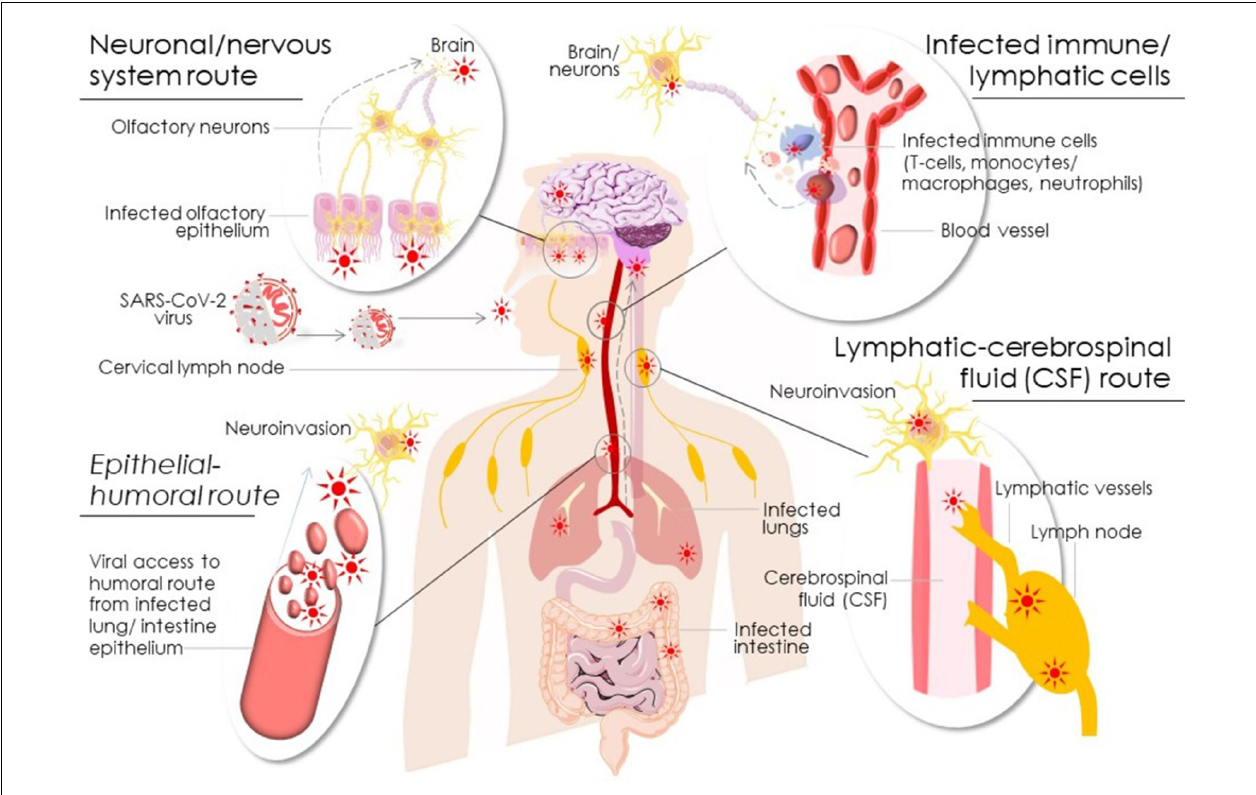
FIGURE 2 | Schematic diagram showing potential modes of SARS-CoV-2 neuroinfection via neuronal/nervous, epithelial-humoral, infected immune/lymphatic, and lymphatic-cerebrospinal fluid